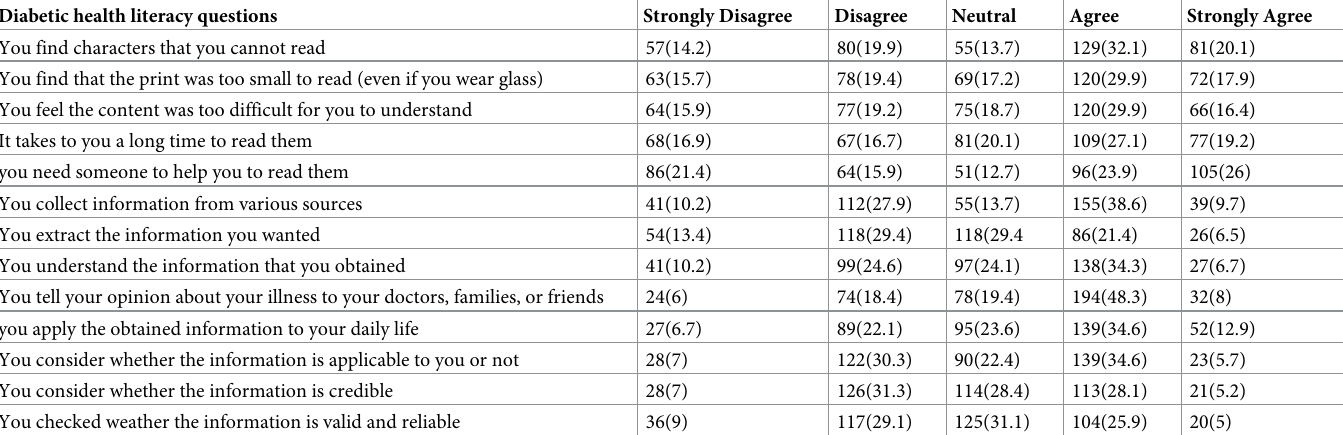
Table 4. Diabetic health literacy of diabetic patients at the outpatient clinic of public health hospitals, Bale Zone, 2021(n = 402). Diabetic health literacy